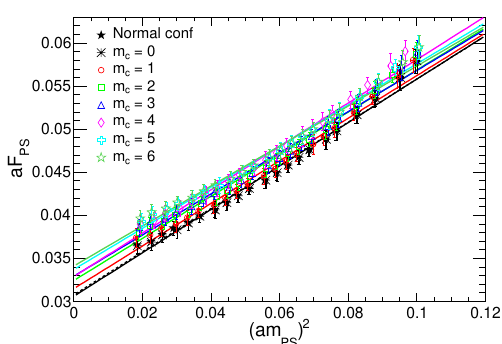
Figure 13 . The decay constant aF PS versus the square of the pseudoscalar mass ( am PS ) 2 . The colored symbols and lines represent the nu- merical results and (cid:12)tting results, respectively. The black dotted line indicates the (cid:12)tting result of the normal con(cid:12)guration.